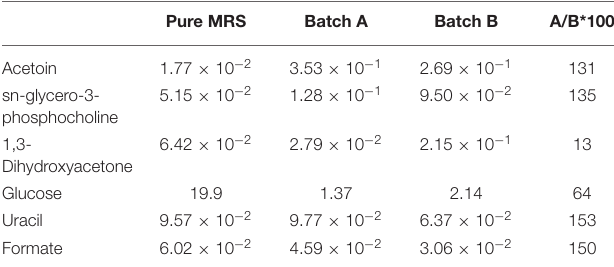
TABLE 1 | Concentration of the molecules identified in MRS and VSL#3 cultures incubated for 44 h (mmol/l of suspension), which showed a difference of at least 30% between the two samples under consideration after incubation. Pure MRS Batch A Batch B